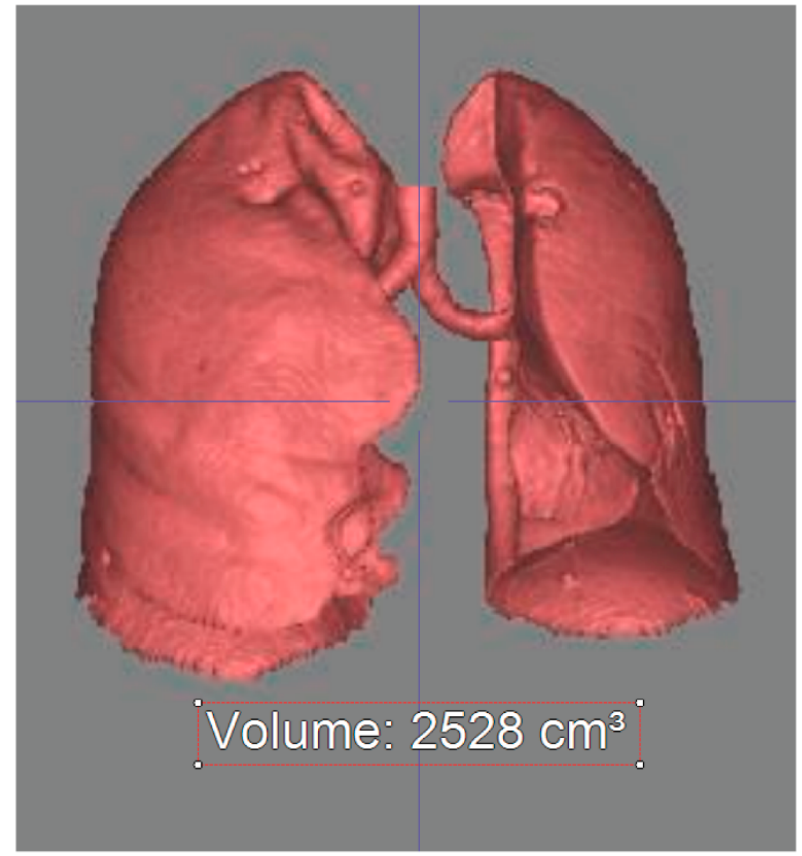
Figure 2. Three dimensional lung volume measurement on chest CT. Anatomical lung volume was measured by using a density mask technique and auto- segmentation technique. Voxels with HU values ranging from − 1024 HU to − 200 were selected on the axial CT images and their volume was measured